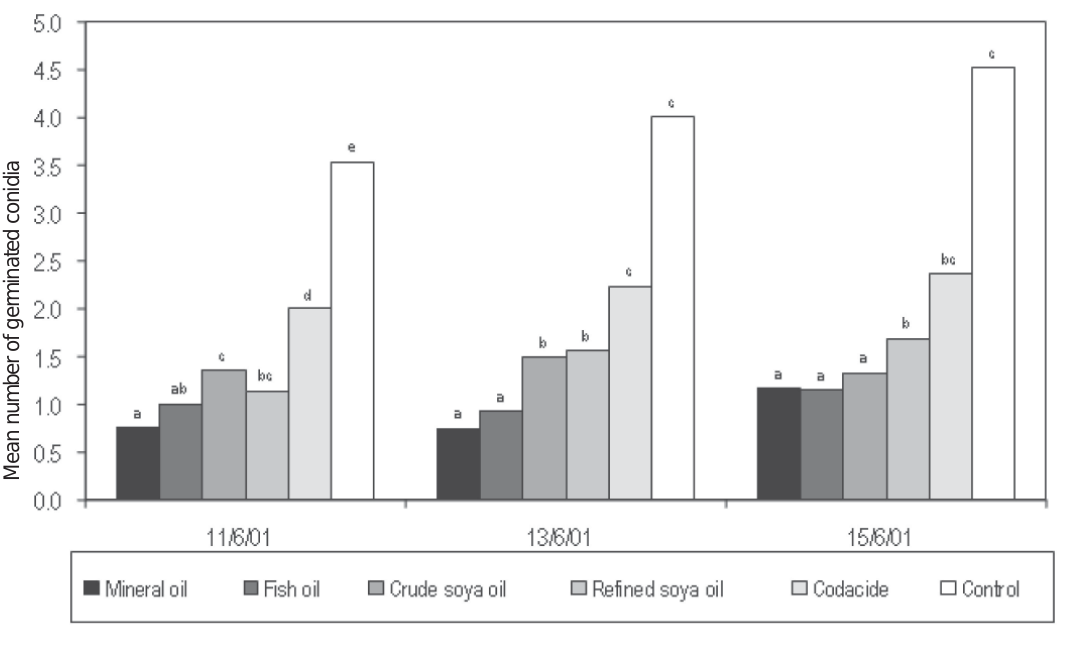
Fig. 2. Mean number of germinated conidia on Mencía leaves inoculated with of Oidium tuckeri and thereafter treated with various